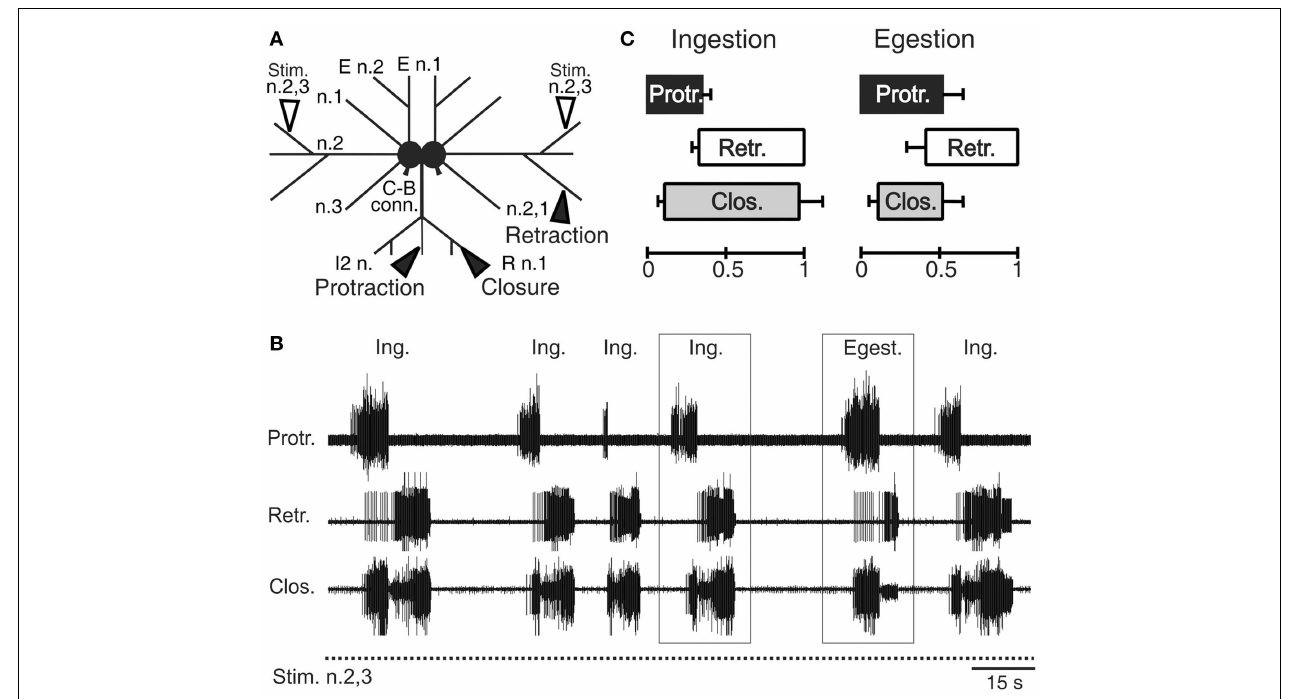
rectangles) of radula protractor (Protr.), retractor (Retr.), and closure (Clos.) motor activity during tonic (2Hz) inciting stimulation of the input nerve 2,3 (Stim. n.2,3).The distribution in time of these radula motor pattern cycles and the durations of the different activity phases are highly variable [see also (C) ] and are not determined by any sensory cue. (C) Based on the relative durations of the protraction/retraction phases and the phase position of closure activity, two distinct motor patterns are distinguishable (also see rectangles in (B) ] that correspond to ingestion (Ing.) and egestion (Egest.) radula movements during actual feeding in the intact